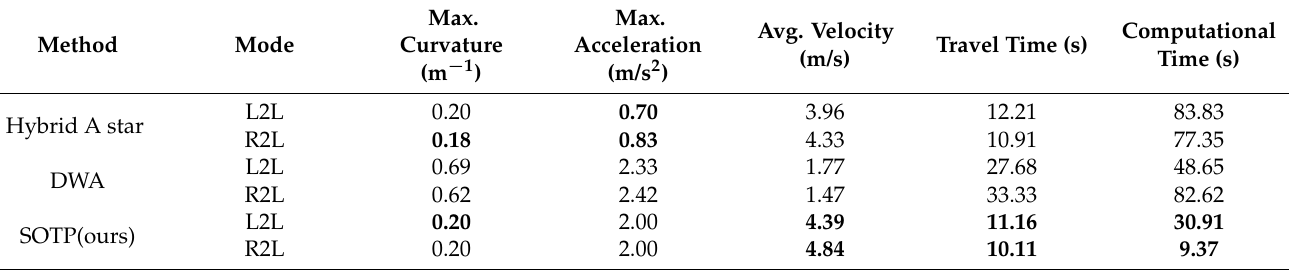
Table 3. The evaluation results.